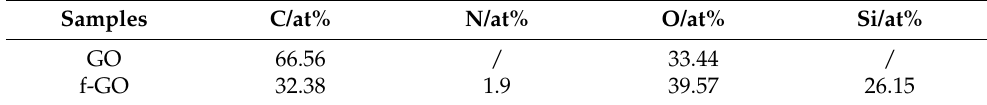
Figure 4. XPS analysis of GO and f-GO nanosheets: C 1s ( a ), O 1s ( b ), N 1s ( c ), Si 2p ( d ). Table 1. The elemental composition of GO and f-GO nanosheets.